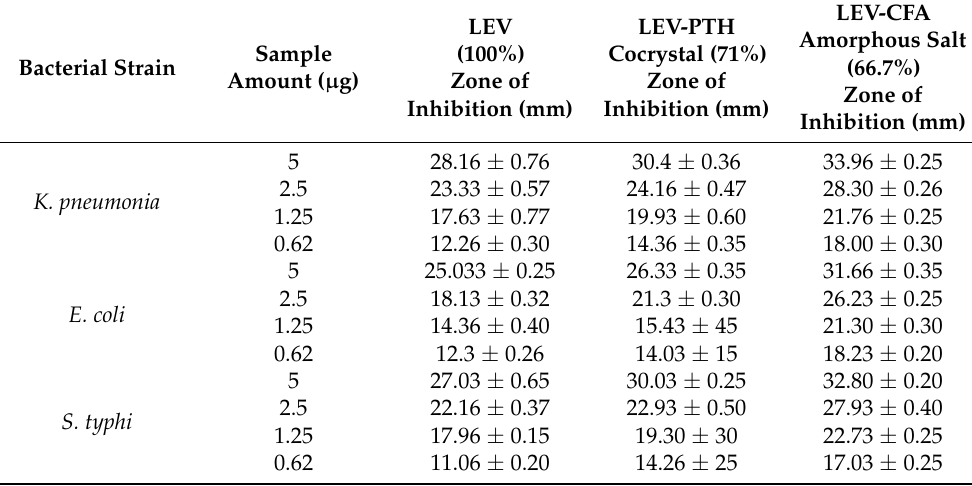
Table 2. Zone of inhibition values of LEV, cocrystal and amorphous salt against different bacterial strains. Bacterial Strain